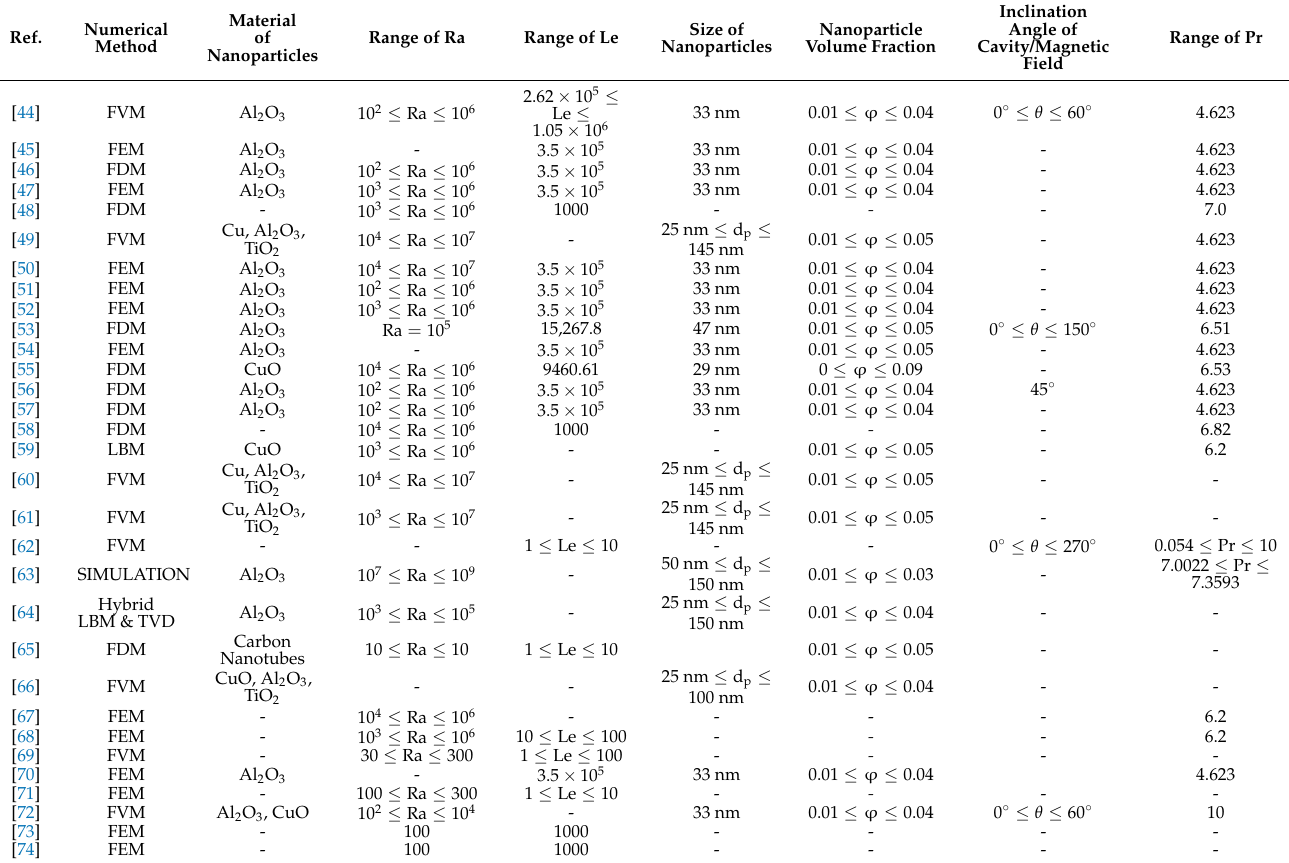
Table 2. Different parameters investigated in